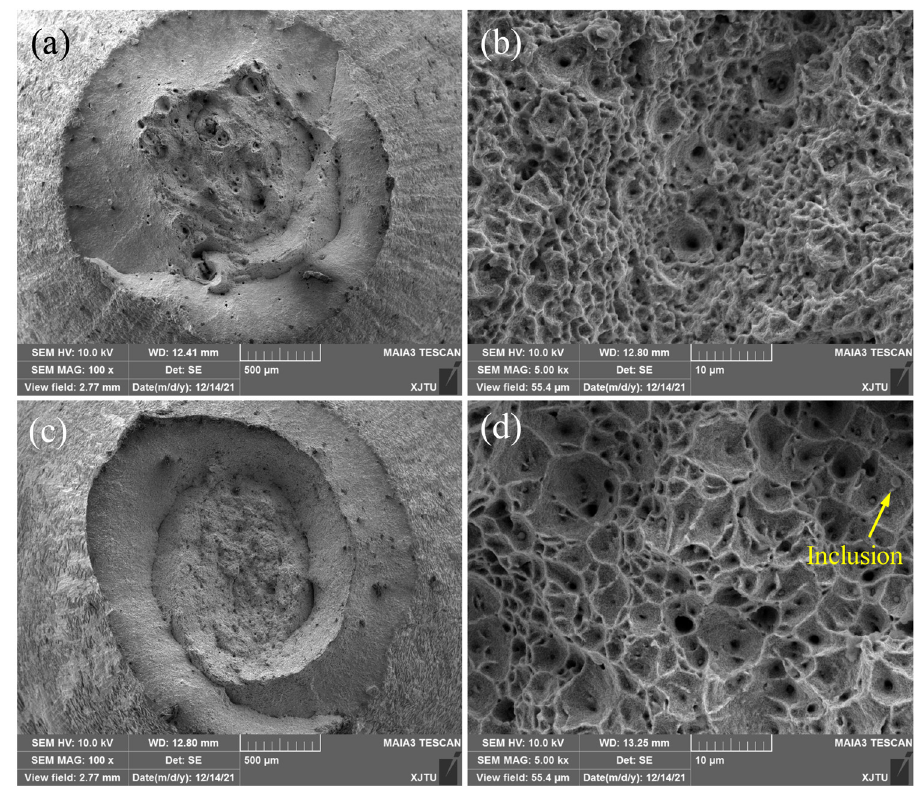
Figure 10: SEM fracture morphologies of the creep ruptured ( a and b ) BM and ( c and d ) WM specimens at 550°C under the stress of 375